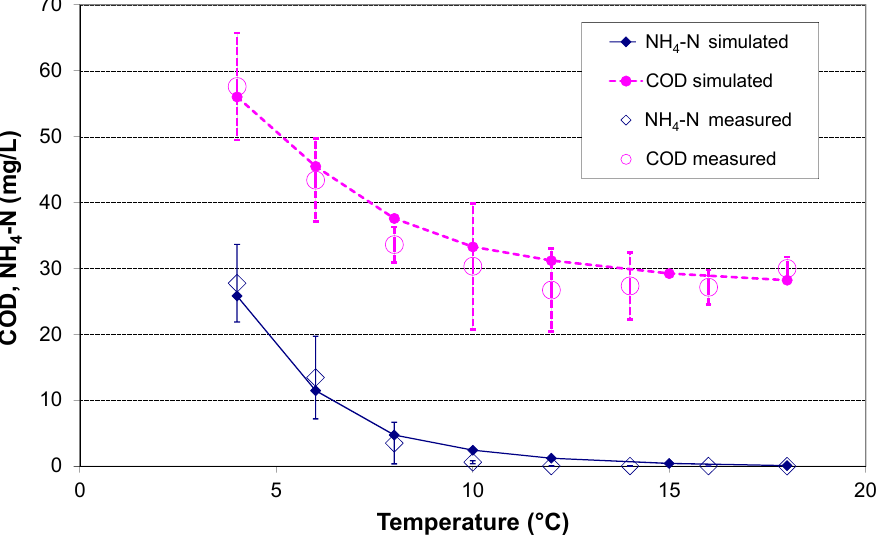
Figure 4. Measured and simulated COD and NH 4 -N effluent concentrations of the experimental VF wetland in Ernsthofen using the modified parameter set (adapted from [17]).